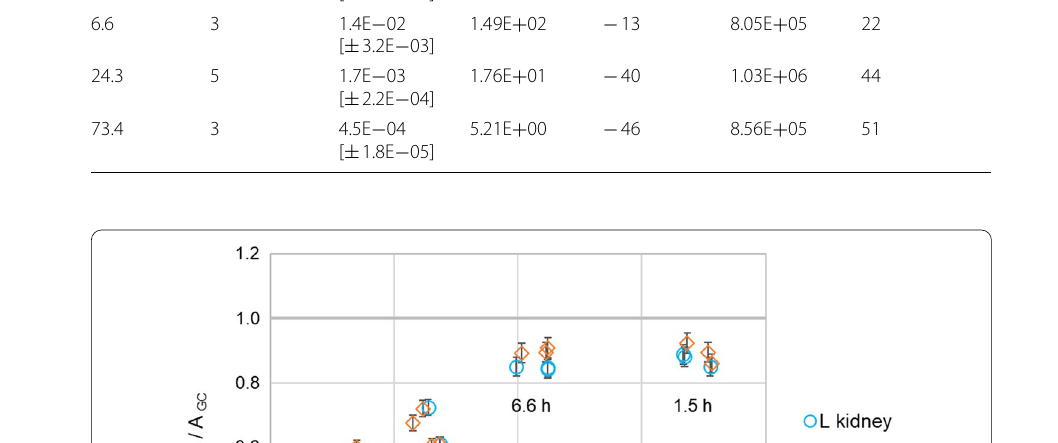
Table 3 Overview of the mean values (of left and right kidneys of all mice per time point) of the FIA / g determined with GC, the reference activity concentration A of A from A . Also, the mean values (of all mice per time point) of the total number of scan SPECT GC counts acquired in the photo-peak window and the percentage of these counts that were used as background and scatter are indicated, for the SPECT acquisitions of dataset SS1 Av. time p.i. No of mice, n GC (dataset GC1) to death (h)